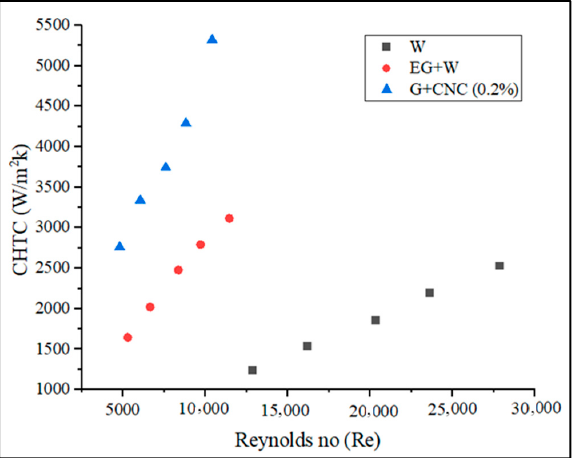
Figure 13. Convection heat transfer coefficient (CHTC) vs. Reynolds number (Re).